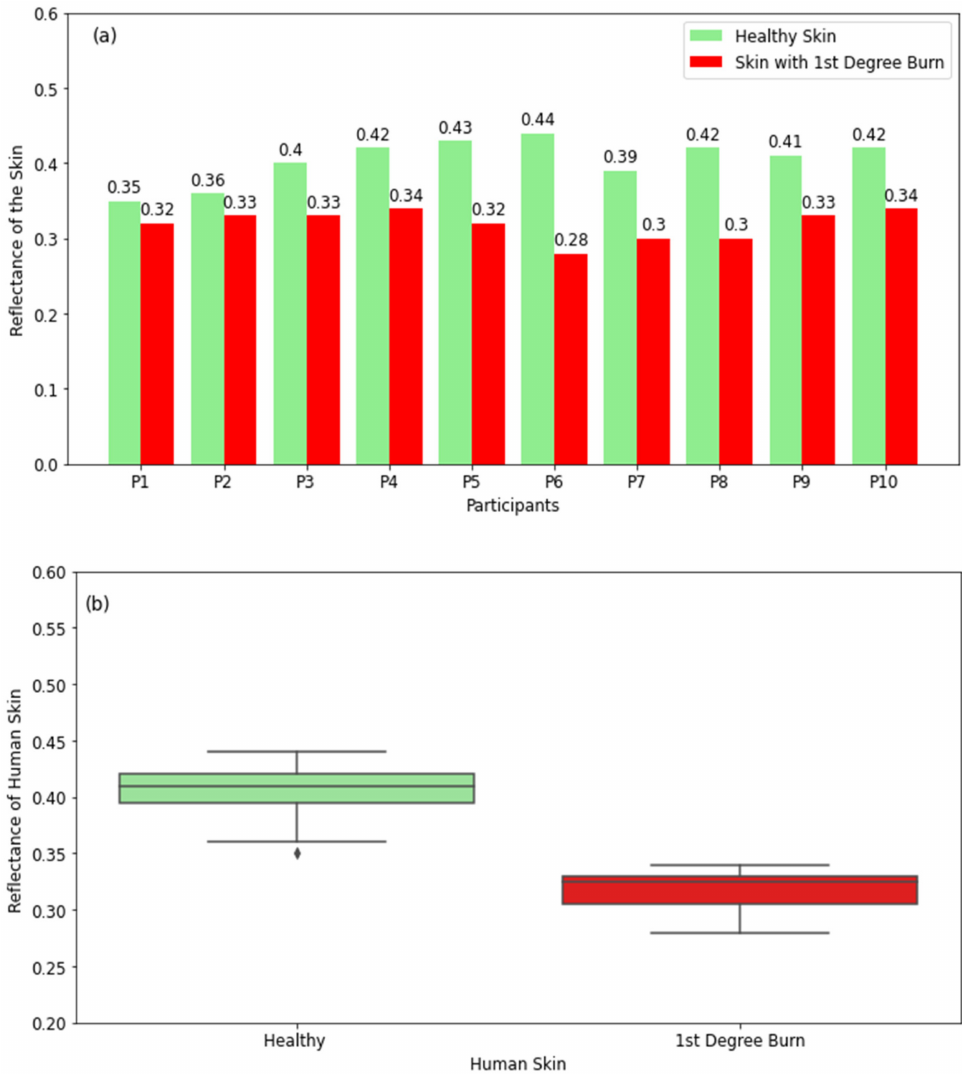
Figure 5. Reflectance measurements in a sample of 10 participants with 1st-degree burns compared with the closest region of unburned (or healthy) skin on the same participant ( a ). The boxplot shows the range of the reflectance of healthy skin and 1st-degree-burned skin ( b ). The symbol ( ♦ ) represents the